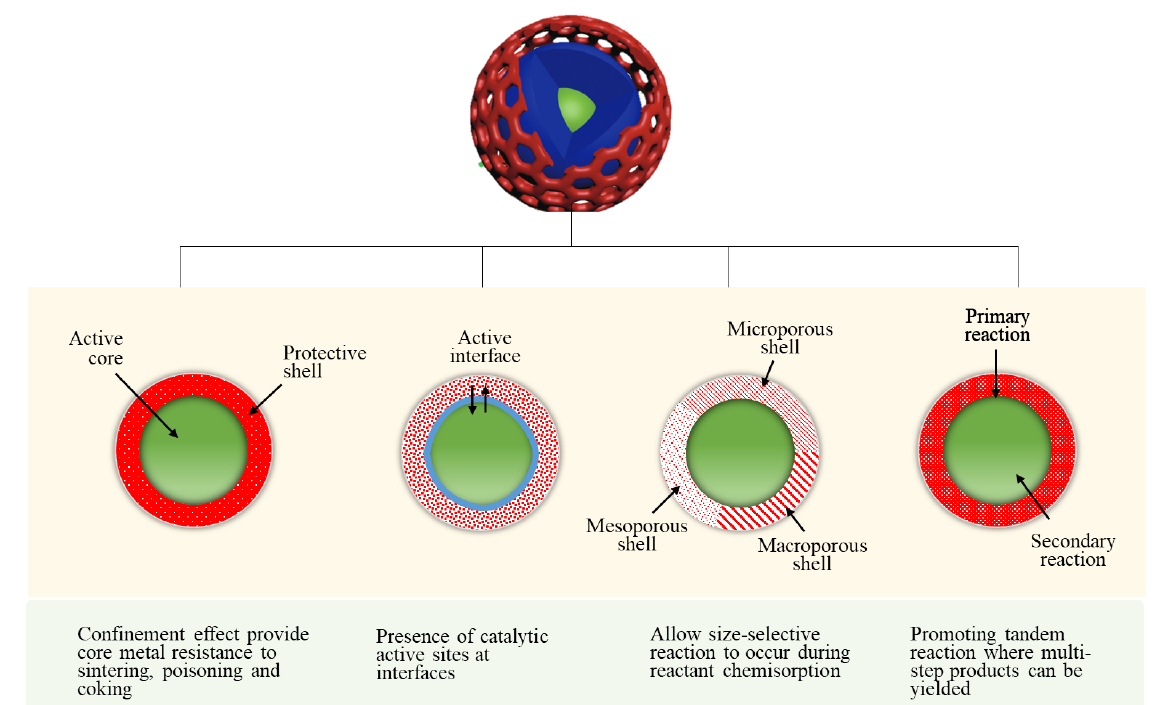
Figure 3. Partial schematic of core-shell structure strategies and significance properties in thermo- catalytic CO 2 conversion. Reproduced illustration with permission from Das et al. [3], Core-shell structured catalysts for thermocatalytic, photocatalytic, and electrocatalytic conversion of CO 2 ; pub- lished by the Royal Society of Chemistry, 2020.